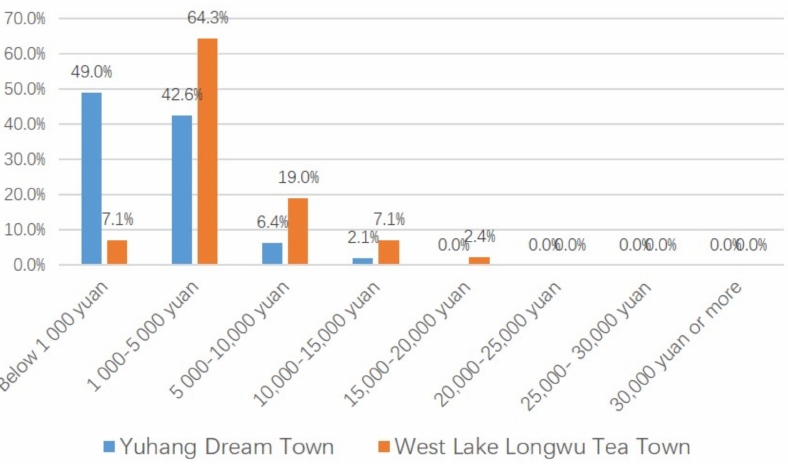
Figure 15. Amount by which respondents’ monthly household income was increased due to the CT practice (source: